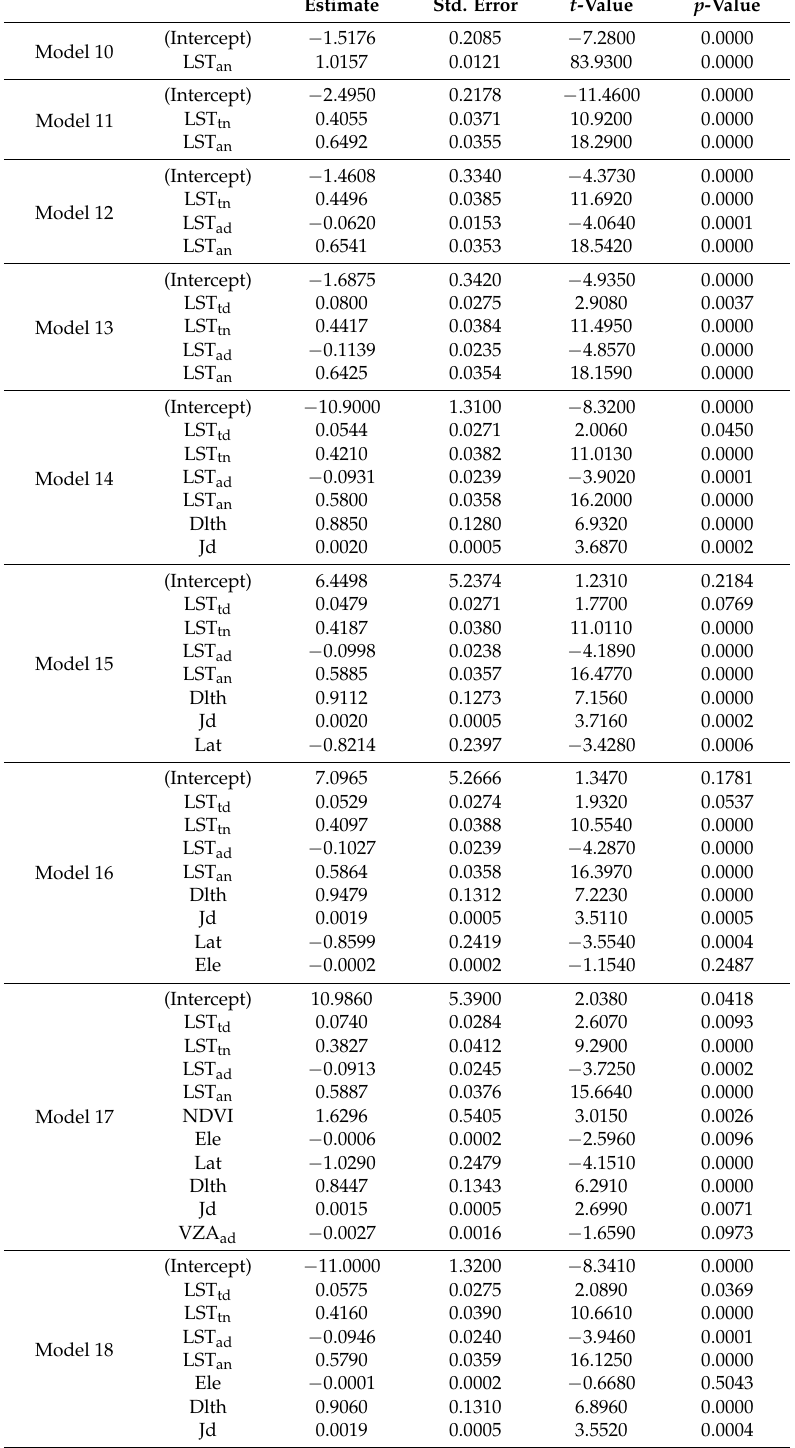
Table B1. Parameters of Models for T a-min